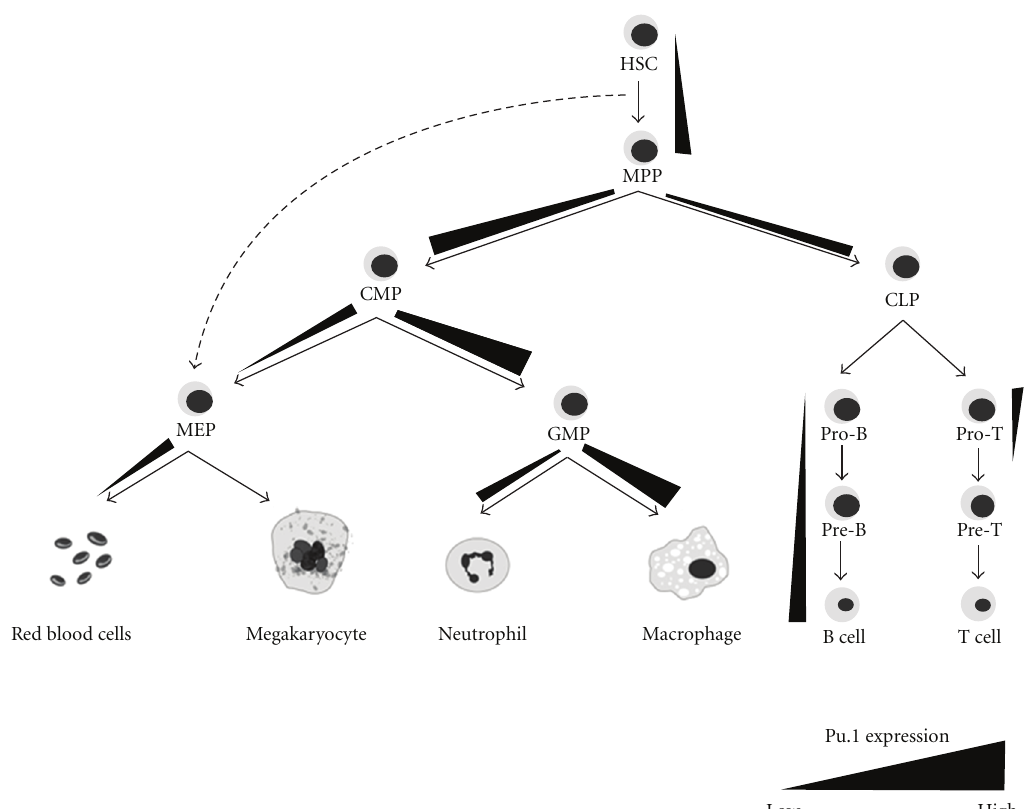
Figure 1: Schematic showing the changing expression of PU.1 during haematopoiesis. PU.1 levels, where known, are represented by gradient bars. Gradient bars are not drawn to scale. Di ff erentiation pathways are denoted by arrows. Abbreviations: HSC, haematopoietic stem cell; MPP, multipotent progenitor; CMP, common myeloid progenitor; CLP, common lymphoid progenitor; MEP, megakaryocyte-erythroid progenitor; GMP, granulocyte-macrophage